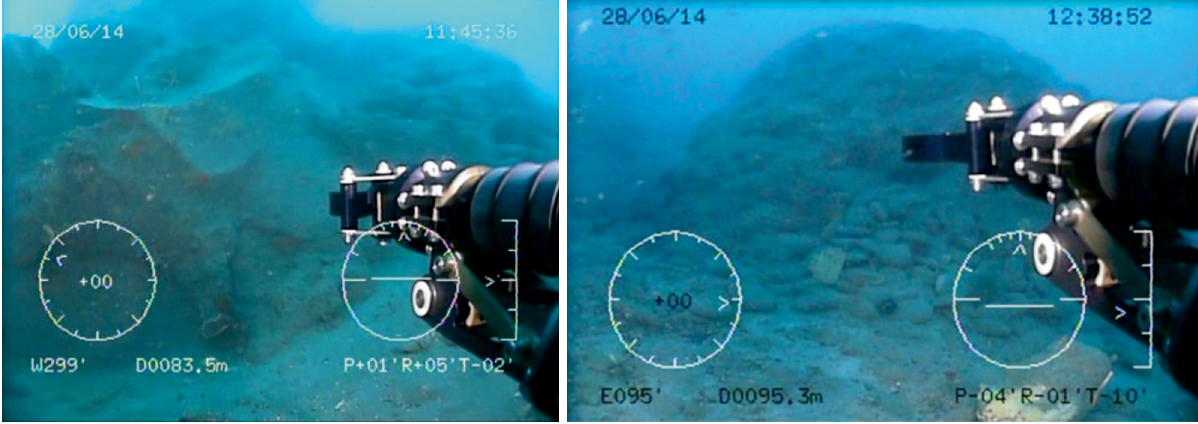
Figure 12. ROV images on Fondachello Ridge displaying, on the left, the outcrop at some 76 m b.s.l. of a massive lava block characterized by conchoidal fractures and, on the right, a mounds-like structure showing a sub-rounded shape with, at its base, a pebble